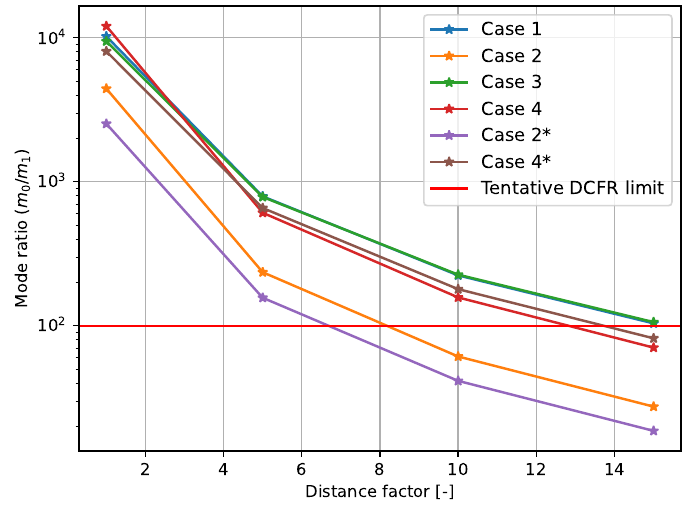
Figure 12. Mode ratio with respect to distance factor.